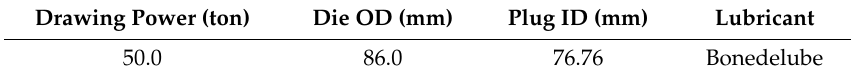
Table 4. Drawing process conditions.